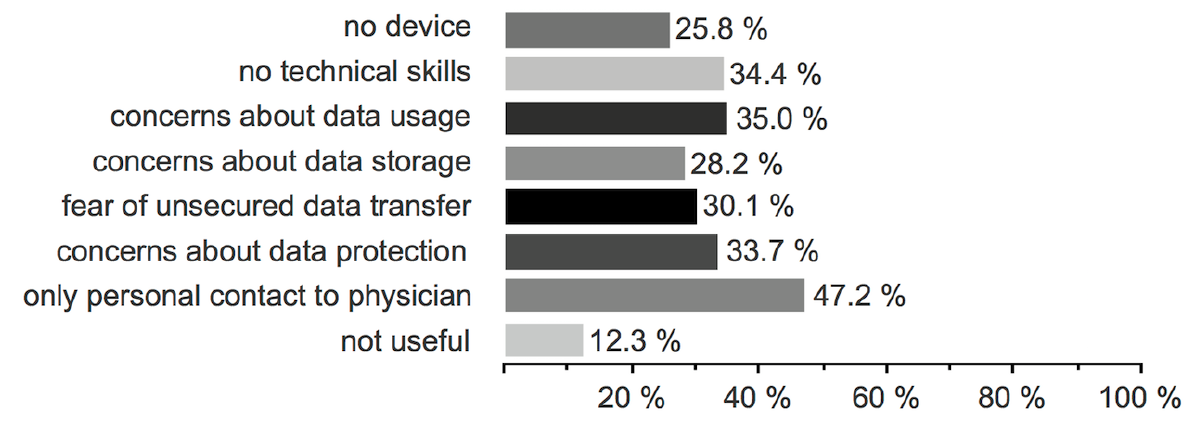
Figure 2. Q9.2: Why would you not send data via an app to your treating clinic?